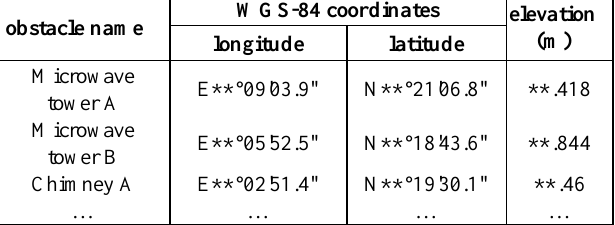
Table 2. Obstacle information of